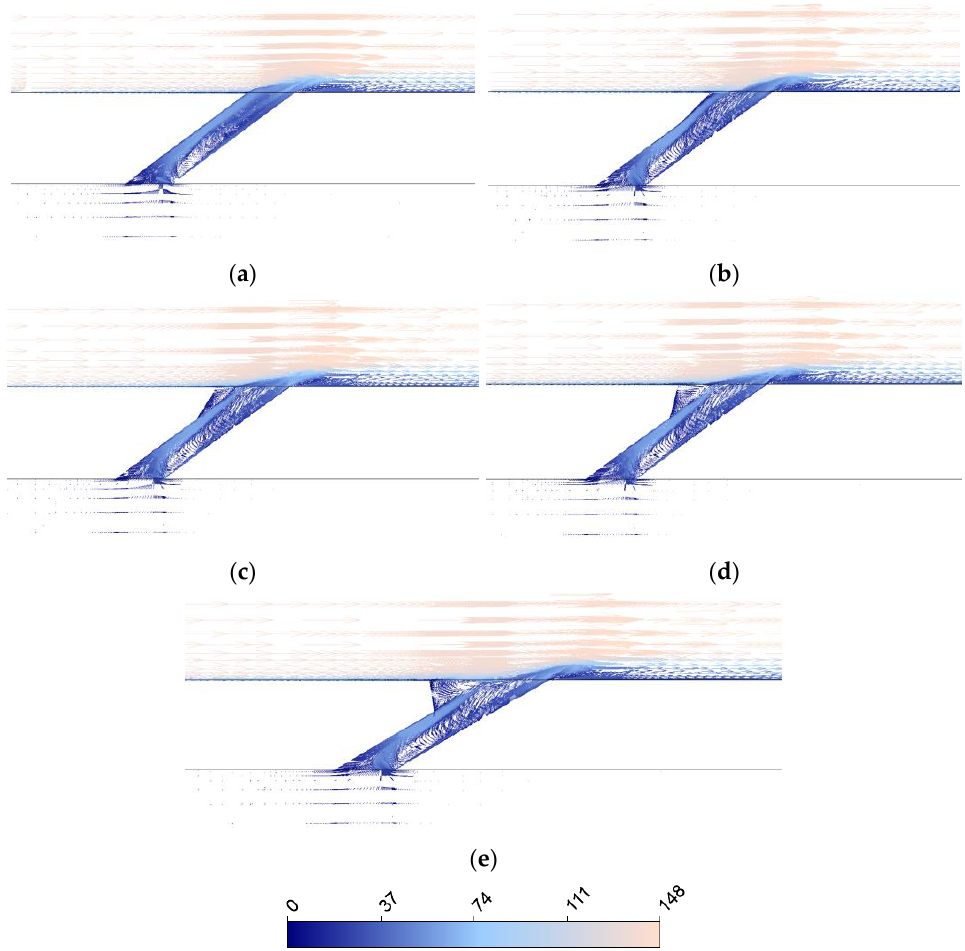
Figure 18. Velocity vectors on x-z plane at y/D = 0 [Unit: m/s]: ( a ) reference, ( b ) F2 = 1.5D, ( c ) F2 = 2D, ( d ) F2 = 2.5D, ( e ) F2 = 3D.